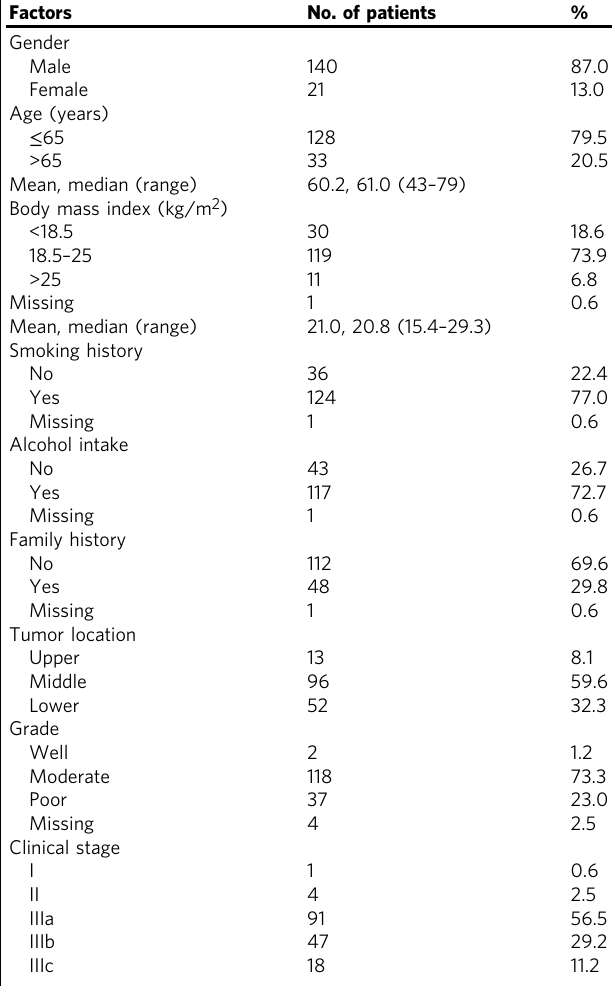
Table 1 Clinicopathological features of 161 patients for pro fi ling cancer gene